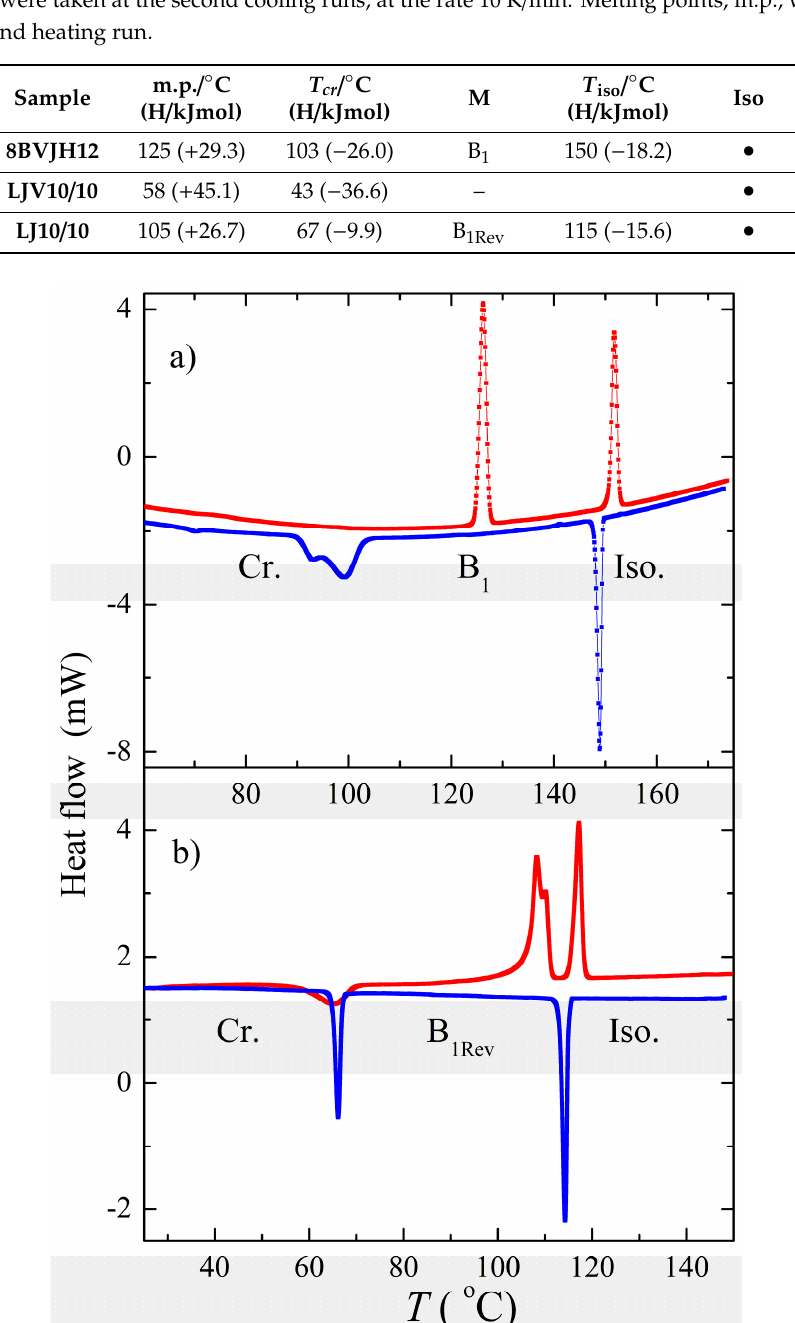
Figure 2. Differential scanning calorimetry (DSC) thermographs for compounds ( a ) 8BVJH12 and ( b ) LJ10/10 . The second heating is presented in red color and the second cooling in blue color. Phases are indicated.